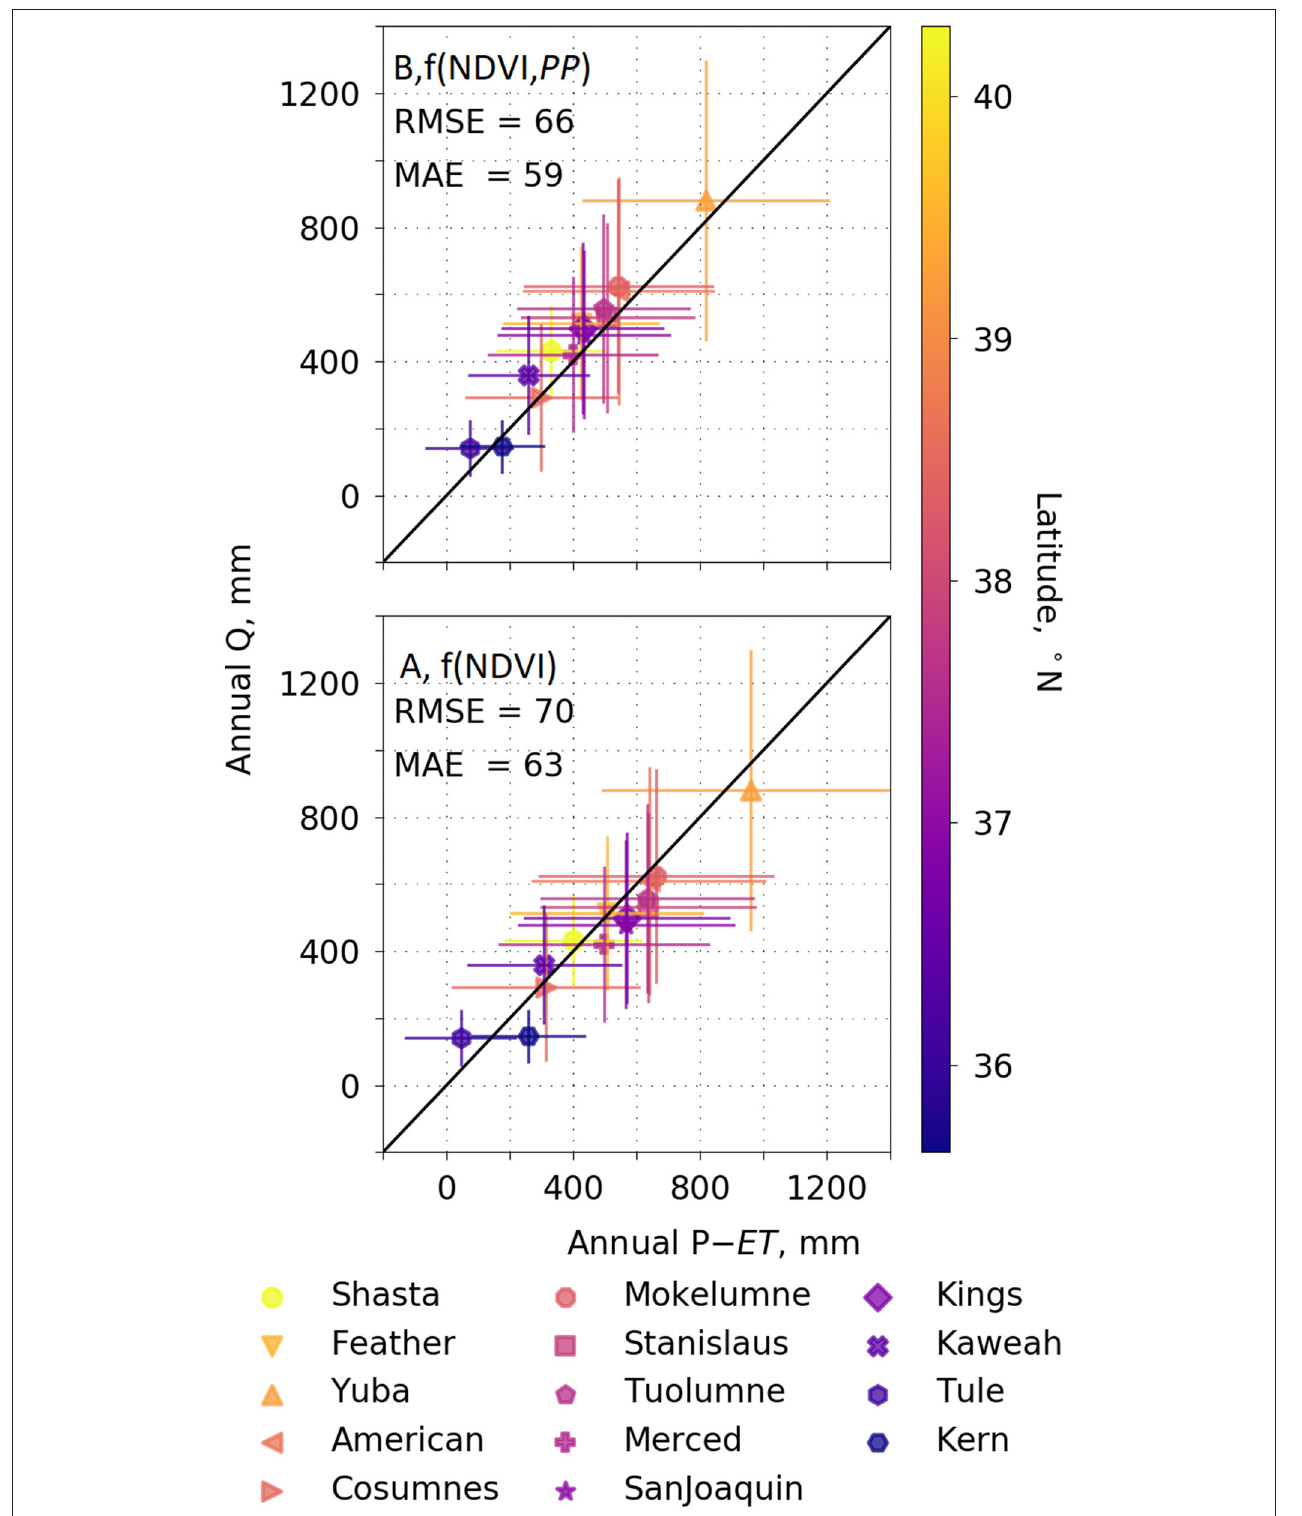
FIGURE 5 | Water-year runoff for each of the 14 river basins on Figure 1 estimated as P – ET , vs. unimpaired flow ( Q ), averaged over 2001–2016. ET in the Upper panel is estimated from f(NDVI, PP) model, and in the bottom panel ET is from f(NDVI) model. Error bars show interannual variability. Annual values of P and ET for each basin can be seen in Supplementary Figure 5 , and P – ET vs. Q by basin are on Supplementary Figure 5 . See Supplementary Figure 6 for a comparison with the other input data and models evaluated.